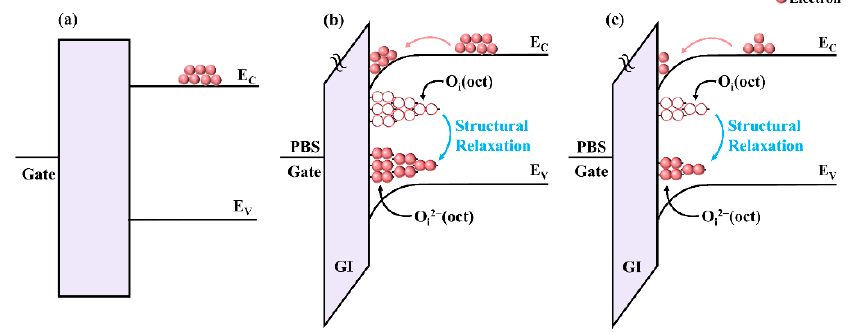
Figure 6. Schematic of the energy-band diagram of the a-IGZO TFTs. ( a ) the energy-band diagram of the TFTs before PBS, ( b , c ) the energy-band diagrams of the undoped TFTs and 20% N-doping ratio TFTs during PBS, respectively. Table 2. Densities of key defect model parameters for a-IGZO TFT fitted with different N-doping ratios after